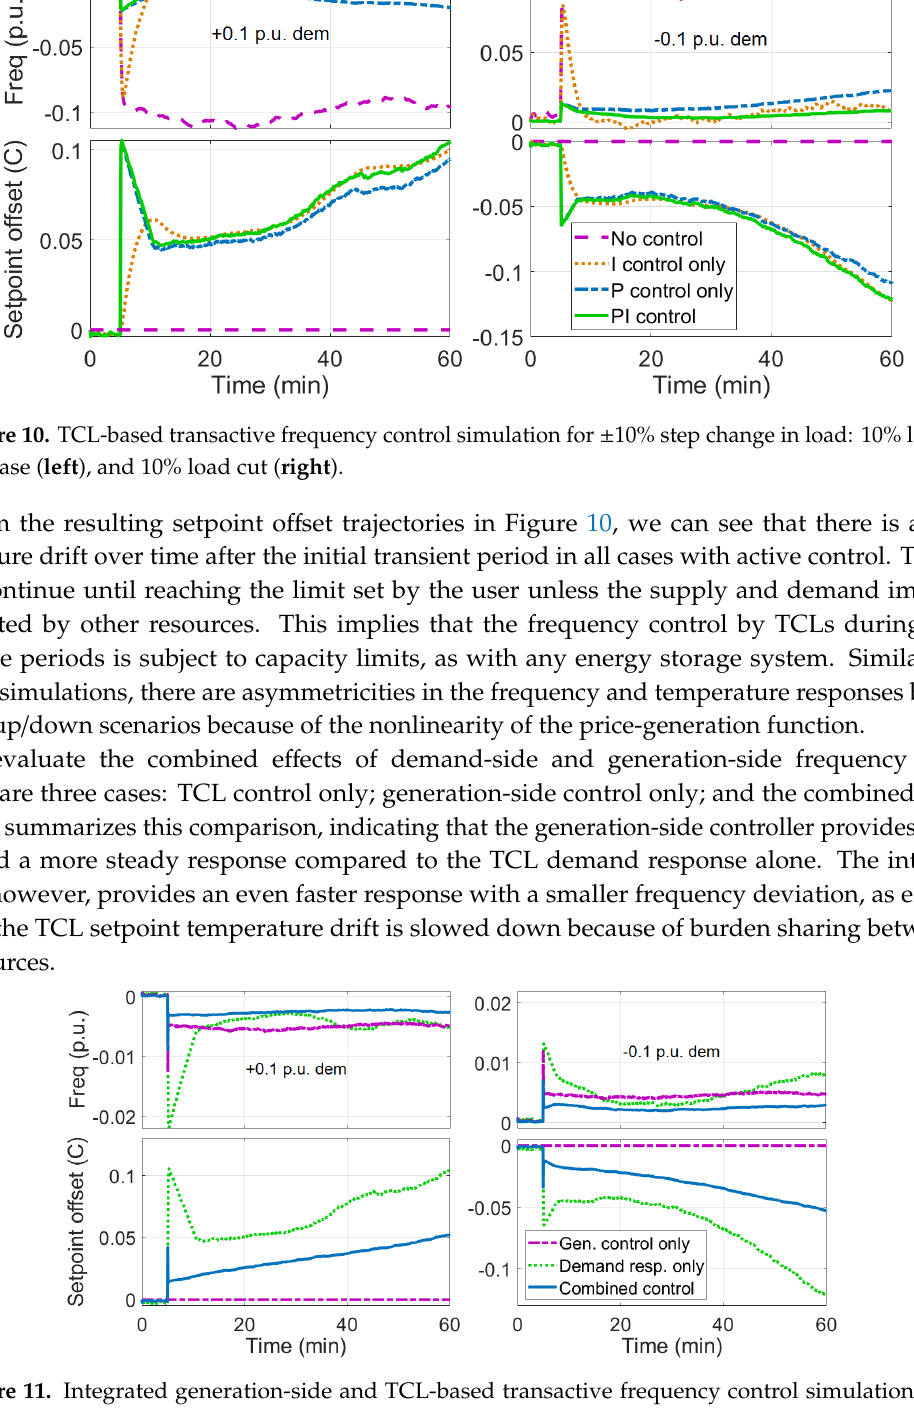
Figure 11. Integrated generation-side and TCL-based transactive frequency control simulation for ±10% step change in load: 10% load increase ( left ), and 10% load cut ( right ).